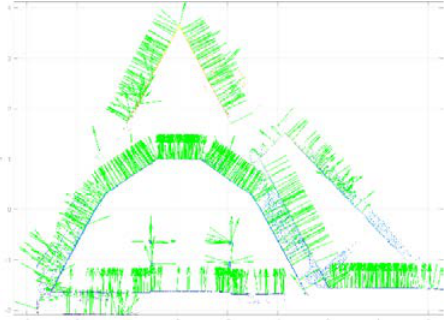
Figure 7: Normal vectors in a 2-D slice of a pair of rafters